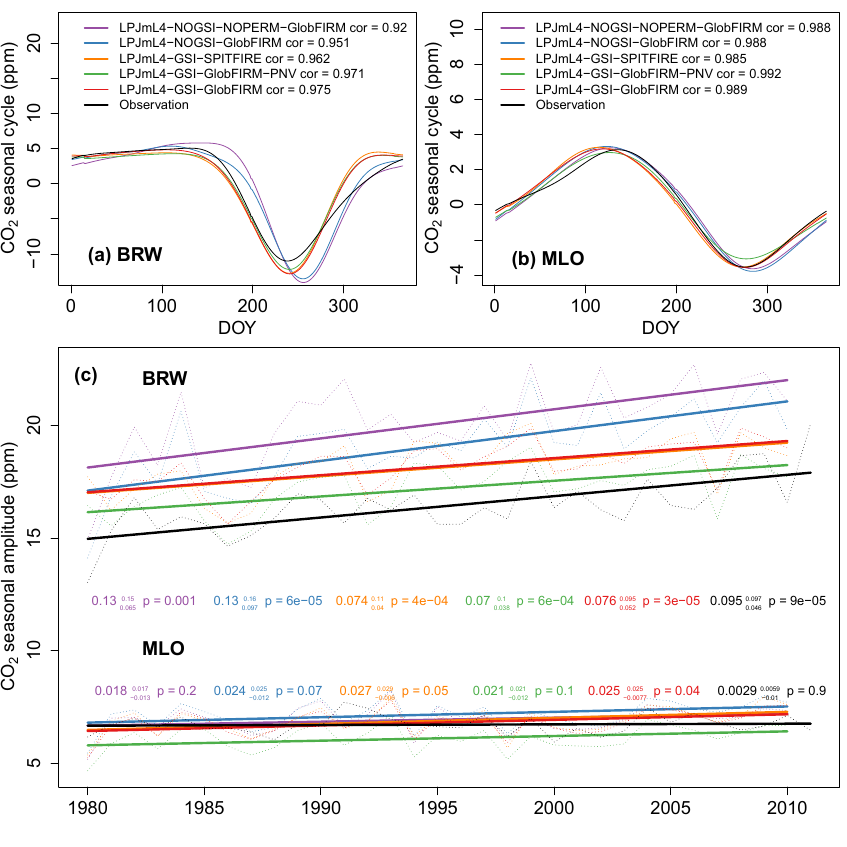
Figure 2. Comparison of the atmospheric CO 2 concentration at Mauna Loa (MLO) and Point Barrow (BRW) simulated in the different LPJmL4 experiments. (a, b) Seasonal cycle, (c) trend of the seasonal amplitude, and slopes are given for the different LPJmL4 experiments.